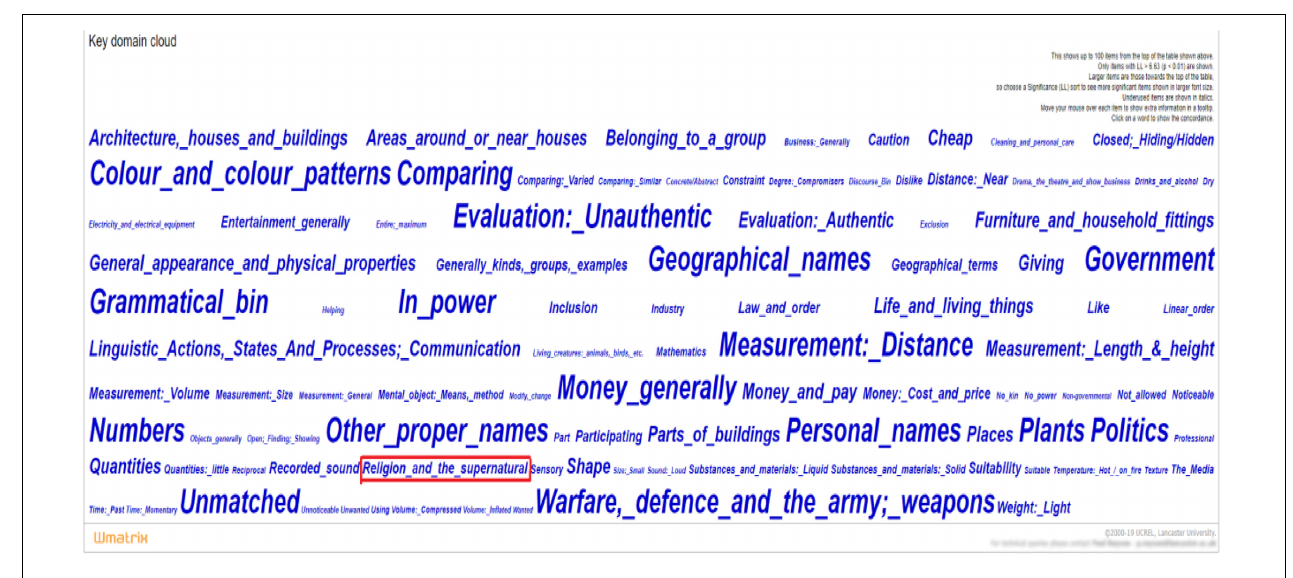
FIGURE 2 | Key underused domain cloud of ten sets of